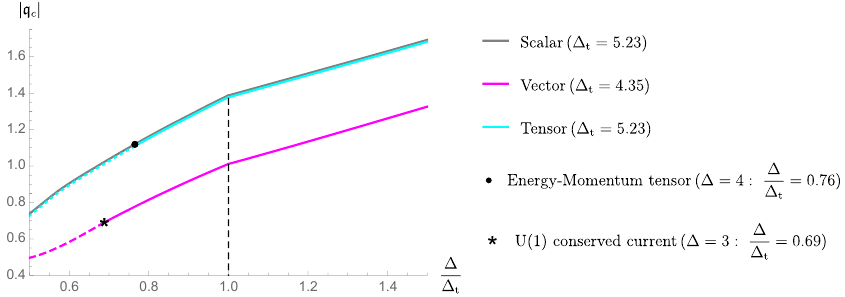
Figure 9 . The radius of convergence of the derivative expansion about the lowest-lying QNMs versus the scaling dimension of the boundary operator, within the range 1 / 2 ≤ ∆ / ∆ t ≤ 3 / 2 . The black dot, which corresponds to transverse perturbations of the metric in the bulk was found in [18]. The dashed parts of the magenta and cyan curves show the values of ∆ excluded by the unitarity bound for the vector and tensor, respectively. The black curve for the scalar operator coincides over the whole range with the cyan curve for the tensor operator. However, for the scalar operator all values of ∆ displayed here are allowed by the scalar’s unitarity bound, ∆ ≥ 2